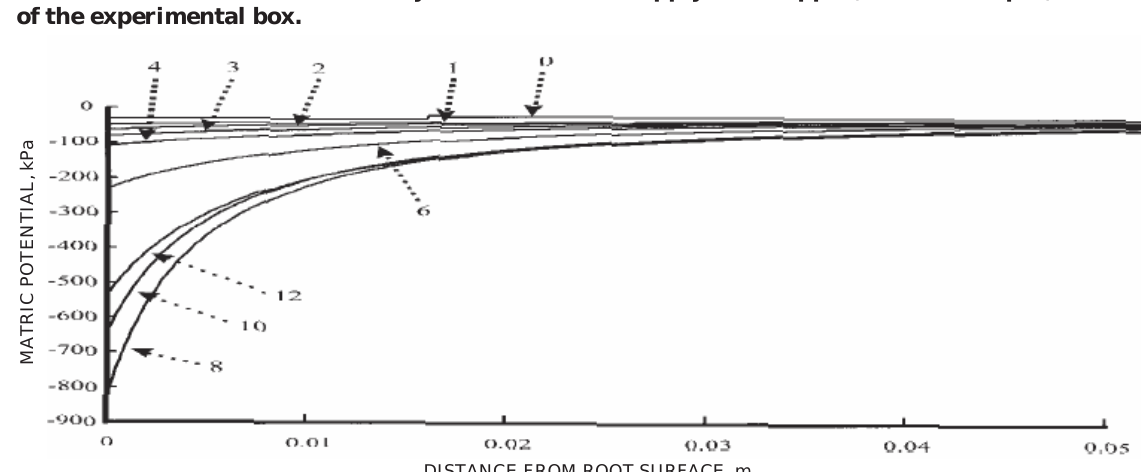
Figure 5. Matric potential as a function of distance from the root surface for the nine reading dates as estimated by equation 16 after fitting to the experimental